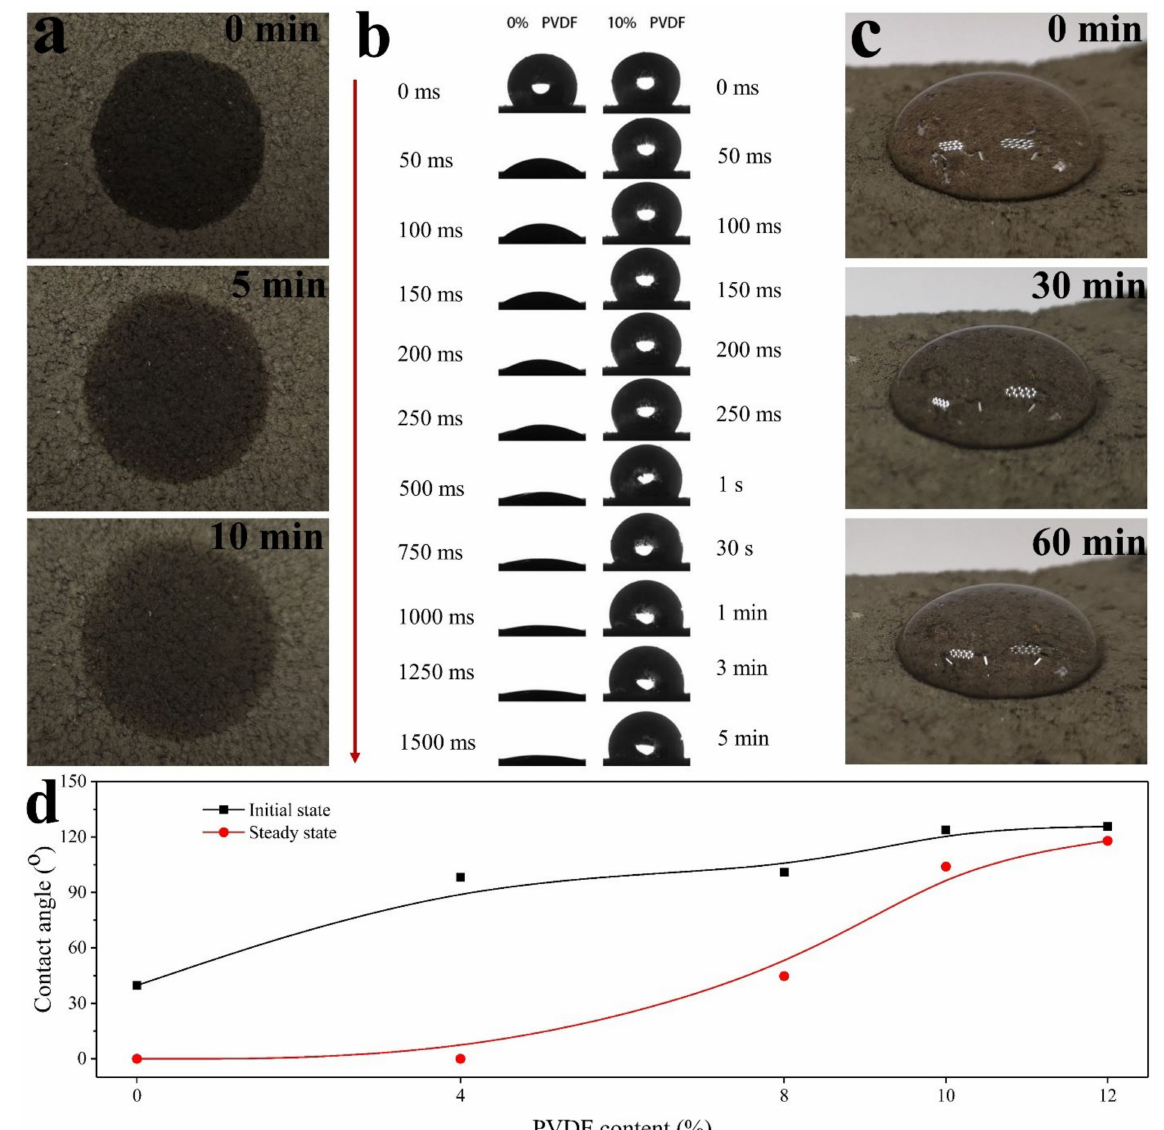
Figure 5. Wettability of PVDF-modified carbonaceous mudstone (PVDF-MCM). Water droplet ( a , c ) and contact angle ( b ) evolution on M-0 ( a ) and M-10 ( c ); ( d ) Contact angles of the modified CM with different PVDF